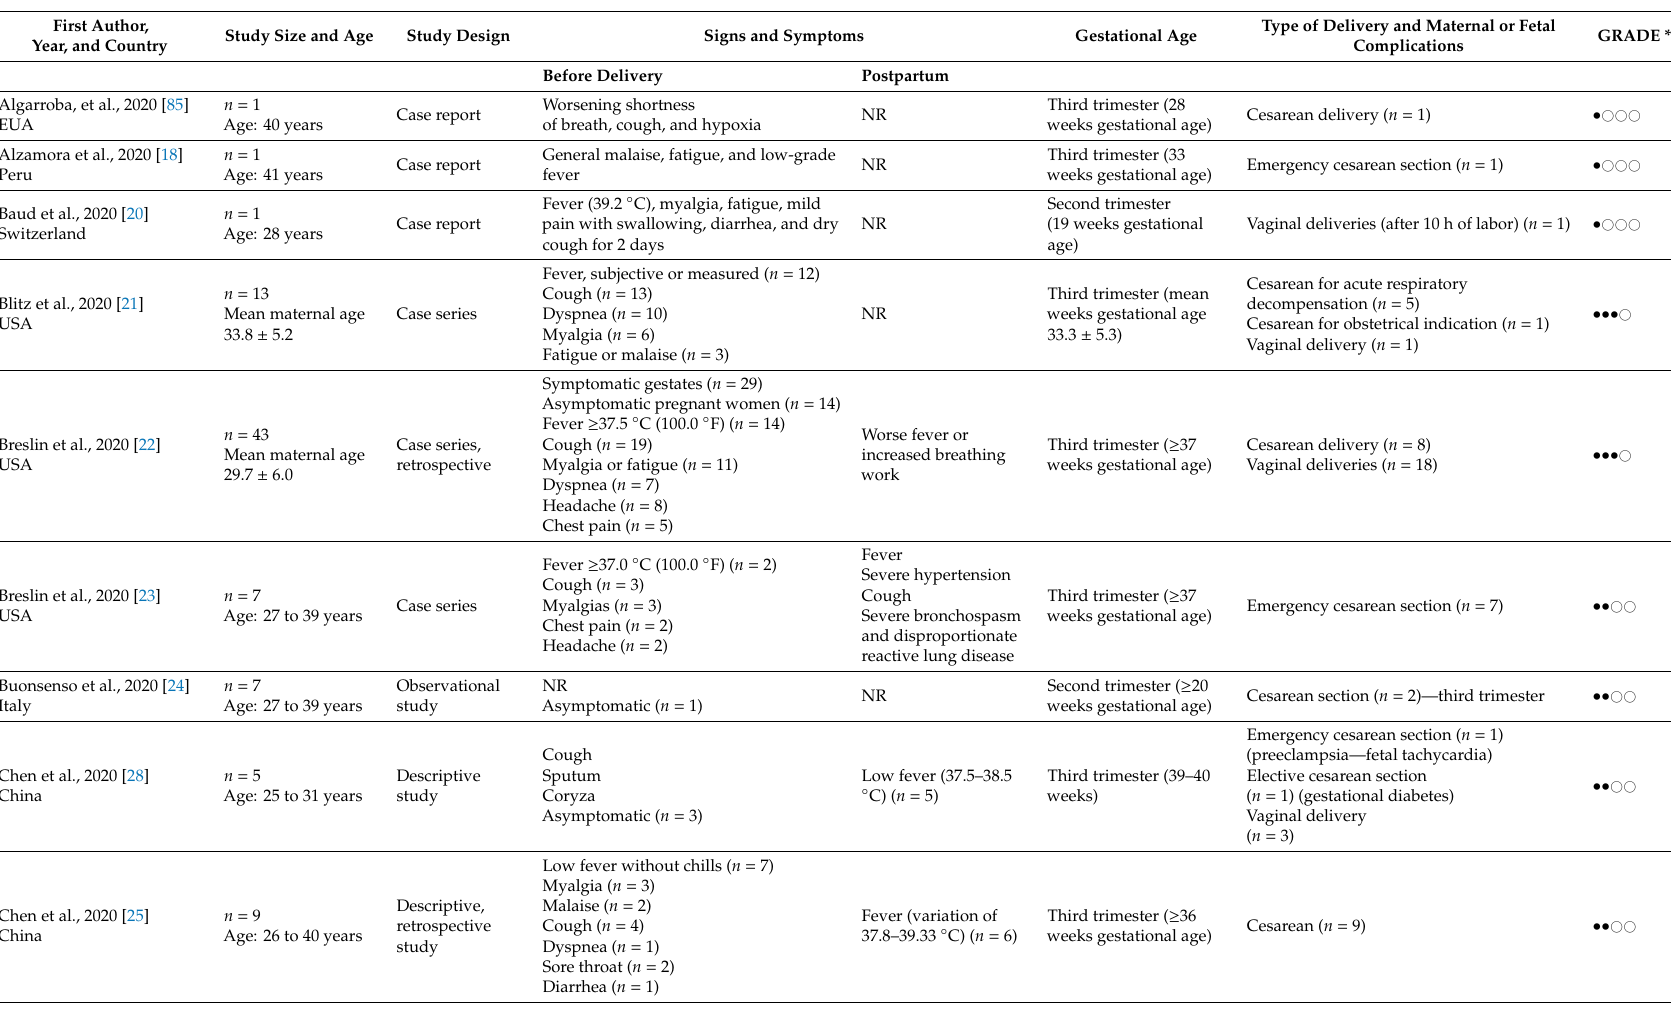
Table 1. Data on signs and symptoms, gestational age, type of delivery, comorbidity, and vertical transmission of coronavirus disease 2019 (COVID-19) in pregnant